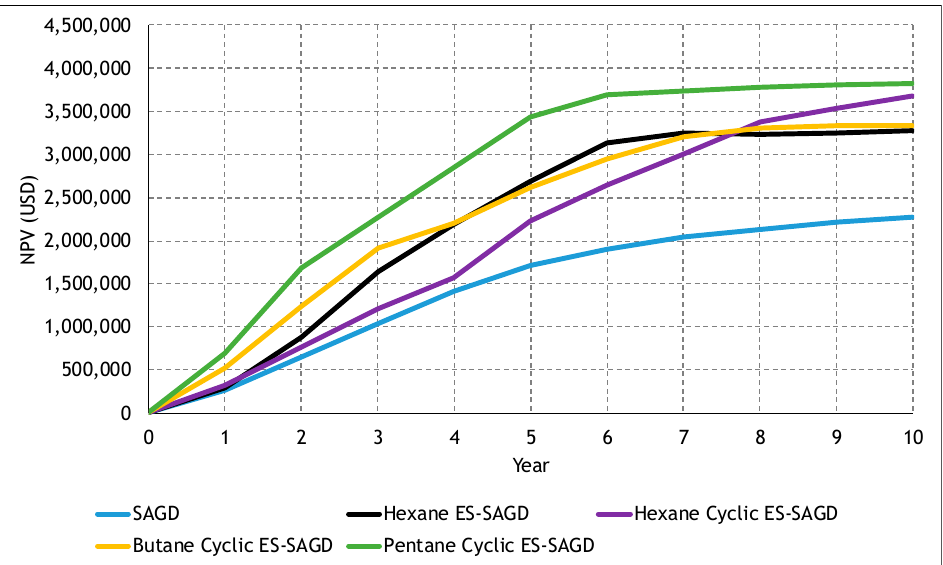
Figure 21. NPV (Net present value) for multiple SAGD cases with solvent and cyclical solvent co-injection.